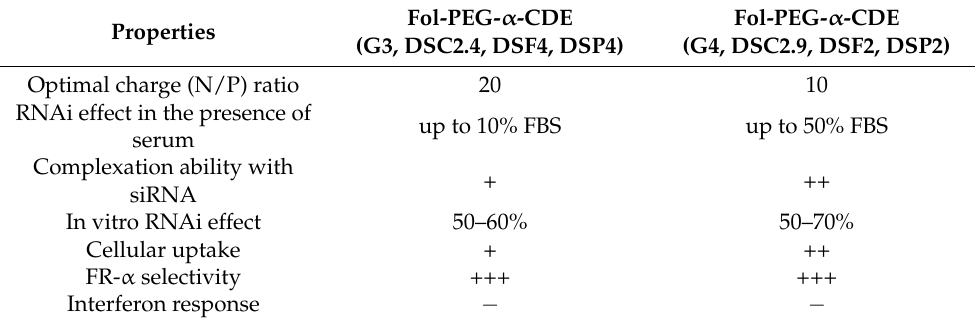
Table 3. Comparison of Fol-PEG- α -CDE (G3, DSC2.4, DSF4, DEP4) and Fol-PEG- α -CDE (G4, DSC2.9, DSF2, DEP2) as siRNA